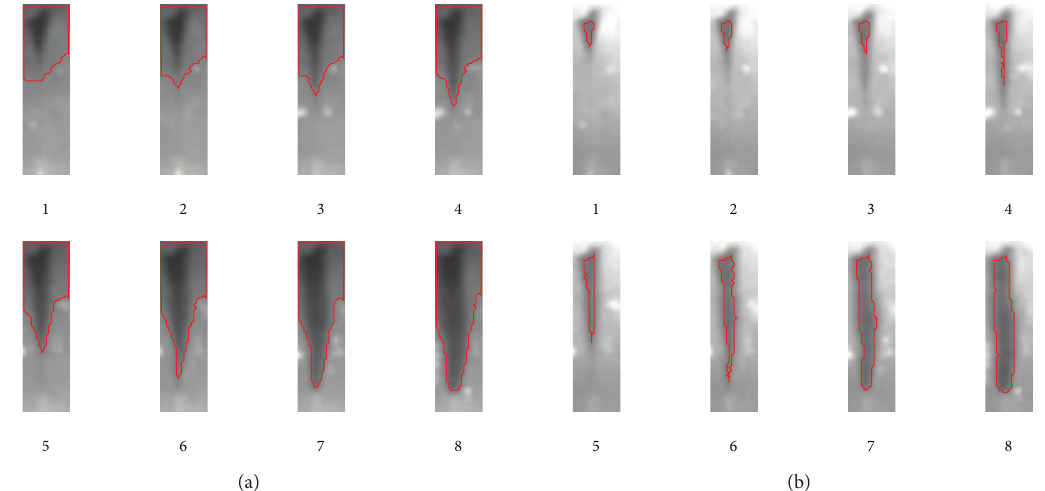
Figure 21: Case 3: Segmented HSV image sequence by the method of [7] (a), the proposed method